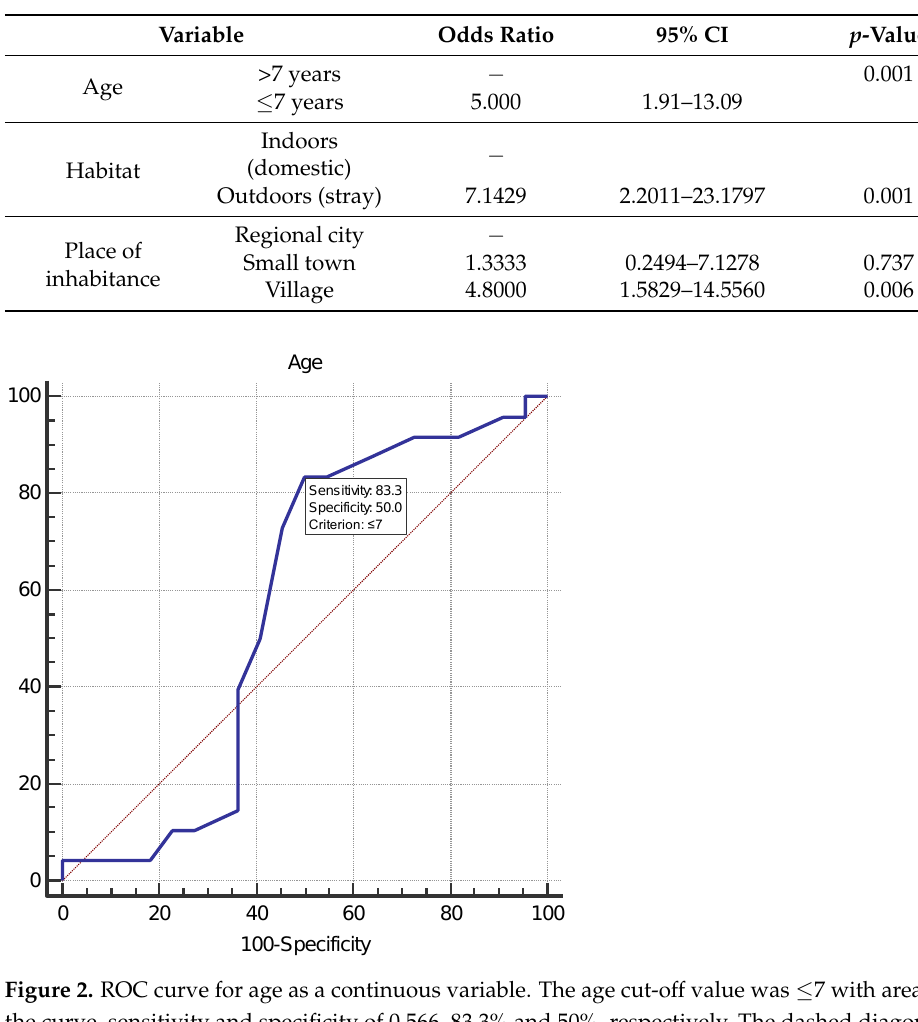
Table 2. Statistical analysis of risk factors for the spread of SARS-CoV-2.